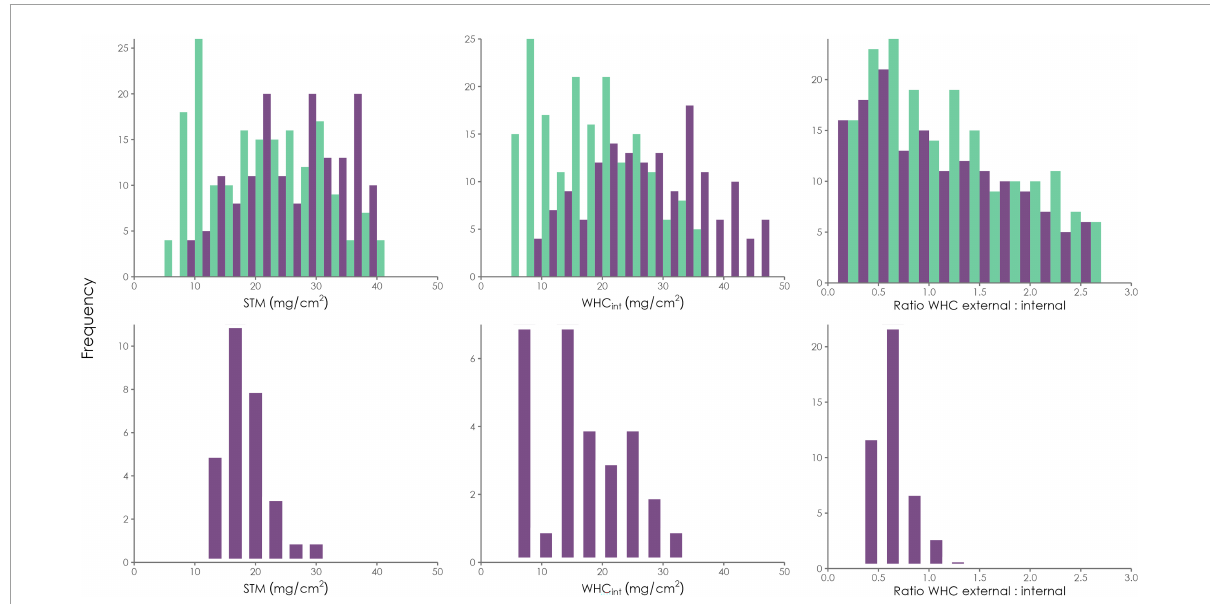
FIGURE5 The initial LiBry strategies are separated into juvenile thalli (light green) and adult ones (dark purple). Frequency distributions of STM, internal WHC, and the ratio of external to internal WHC, both of the initial strategies in the LiBry model (Upper row), and also of the observed adult thalli (Lower row) of which only median values are shown.